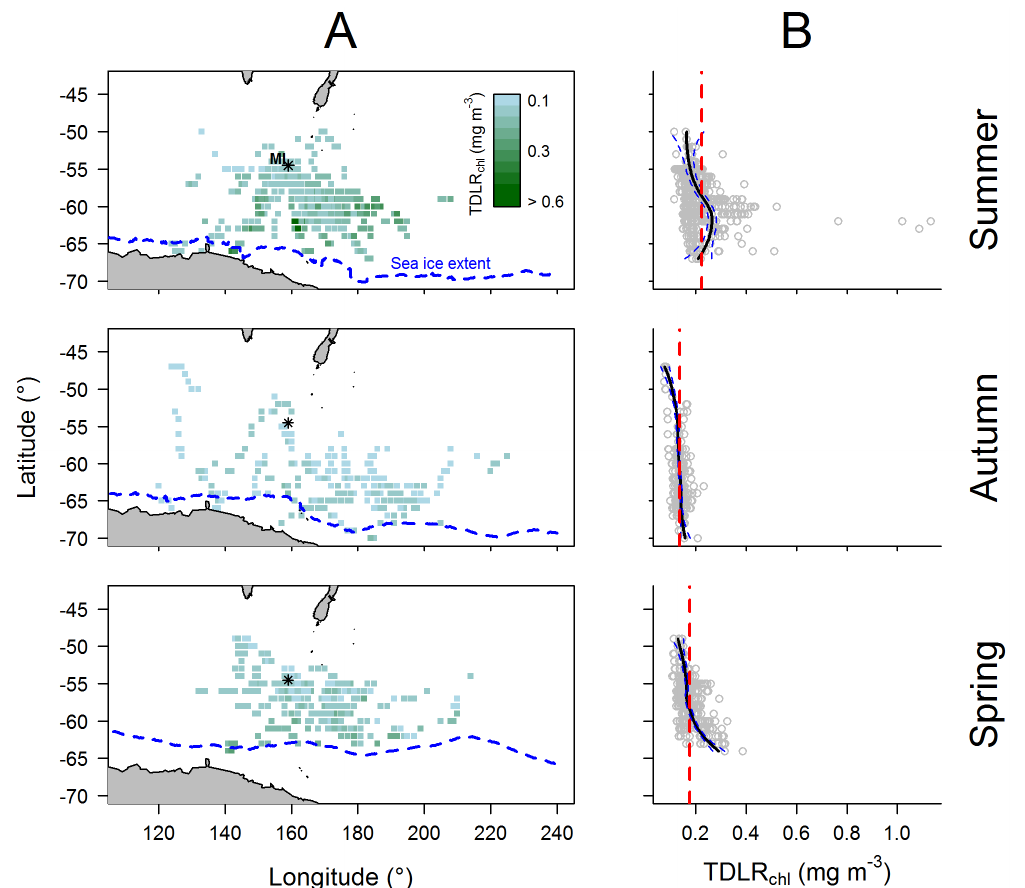
Figure 6. (A) Seasonal spatial distribution and (B) latitudinal patterns of TDLR chl { from the final mixed model. Each map shows the bottom of Tasmania and New Zealand (top), the coast of East Antarctica and Ross Sea (bottom), and the sea ice extent (blue dashed line). The black asterisk shows Macquarie Island. For each corresponding plot (B) the black line represents a loess fit and blue dashed lines represent the 95% confidence level, and the vertical red dashed line represents the mean TDLR chl . { Light-based chl-a estimates from our final mixed model collected by TDLRs.